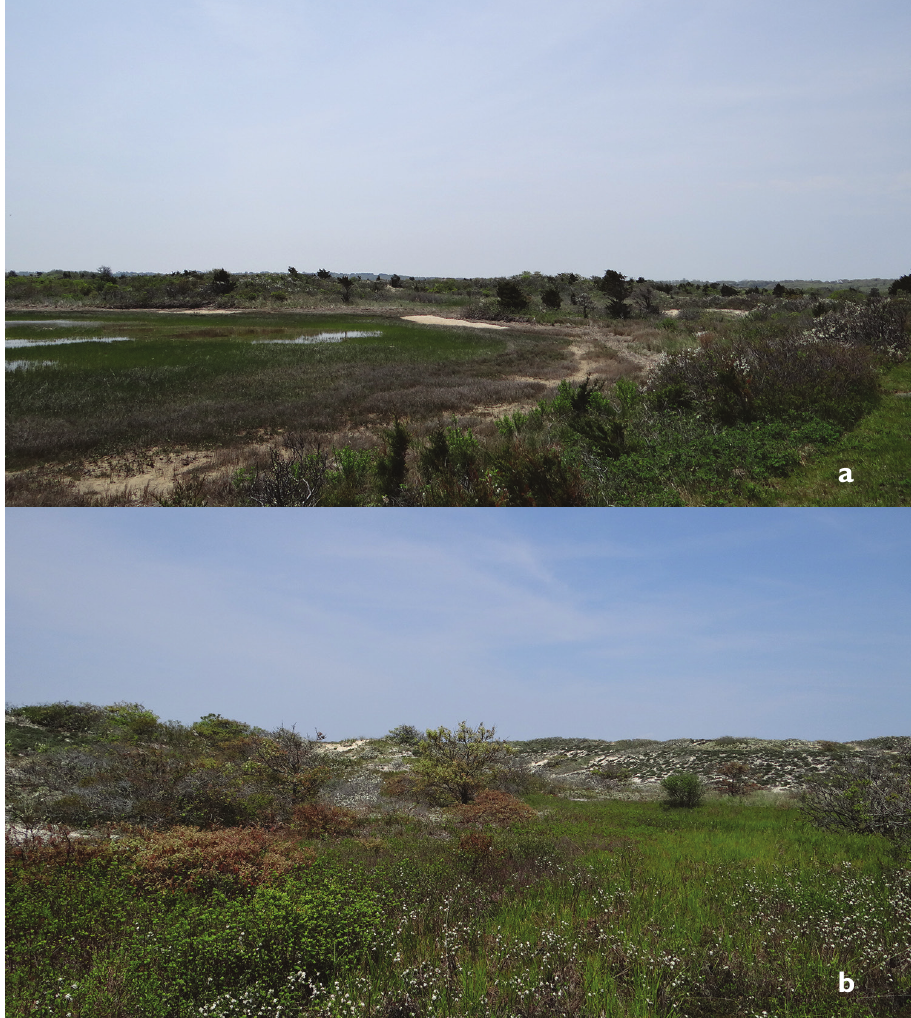
Figures 6. Examples of wetlands interspersed among the Lobsterville Dunes. a Graminoid wetland edged in part with Atlantic white cedar ( Chamaecyparis thyoides (L.) Britton, Sterns & Poggenb.) b Backdune wetland supporting a colony of black chokeberry ( Aronia melanocarpa (Michx.)